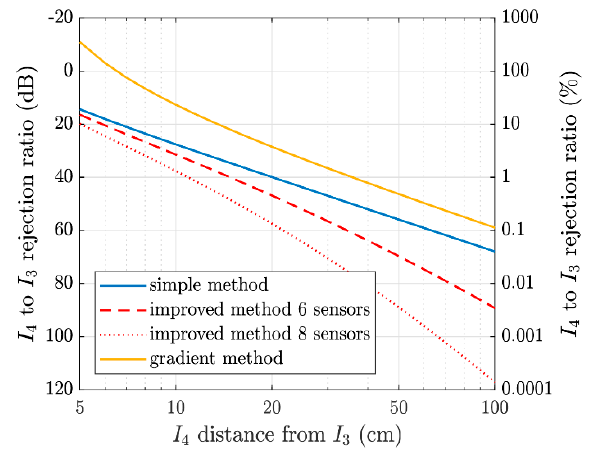
Figure 4. Theoretical comparison of different current measurement methods.